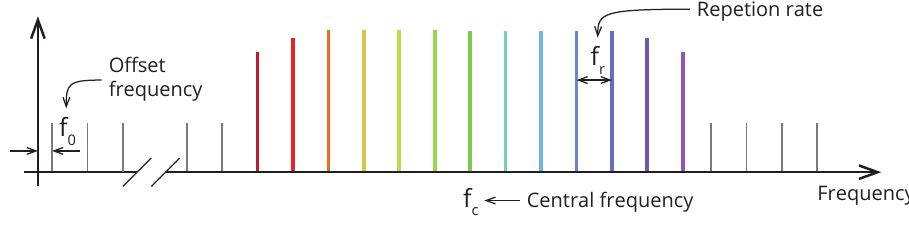
Figure 1. A frequency comb in the frequency domain. The comb is fully characterized by the repetition rate f r , which defines the line spacing, and either the offset frequency from zero f 0 or the central frequency f c